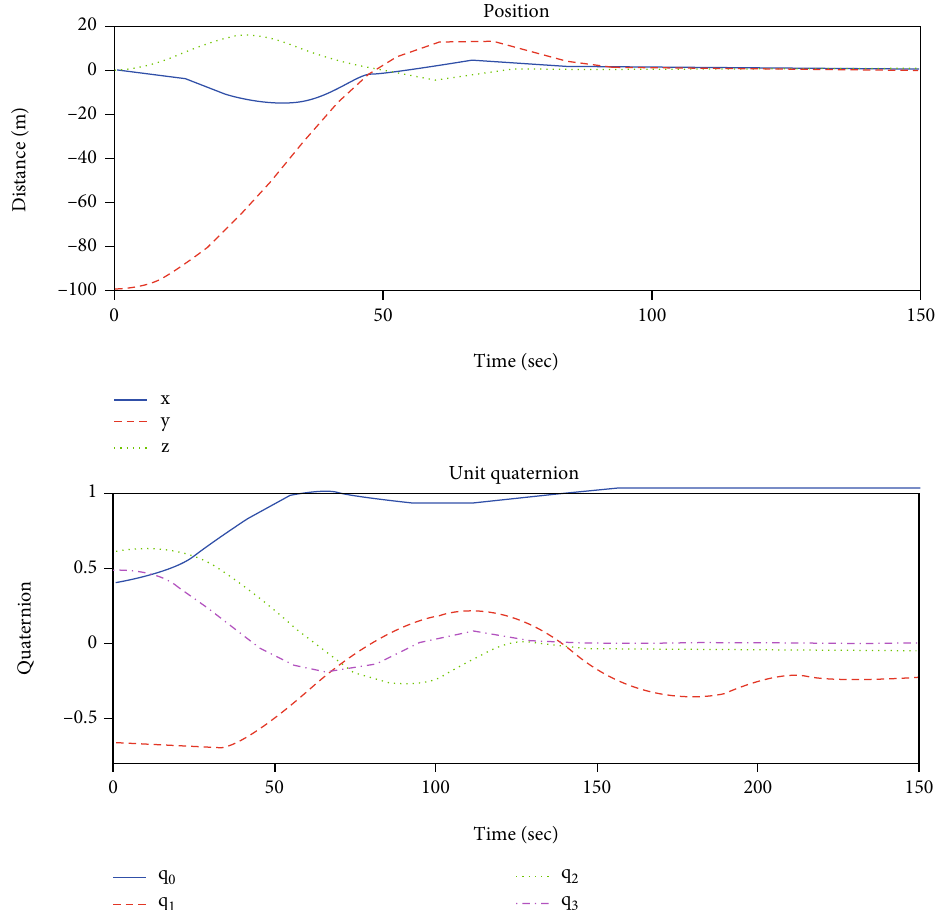
Figure 10: Time histories of control forces and torques expressed in the body- fi xed frame with the prediction of 15 sampling instances.